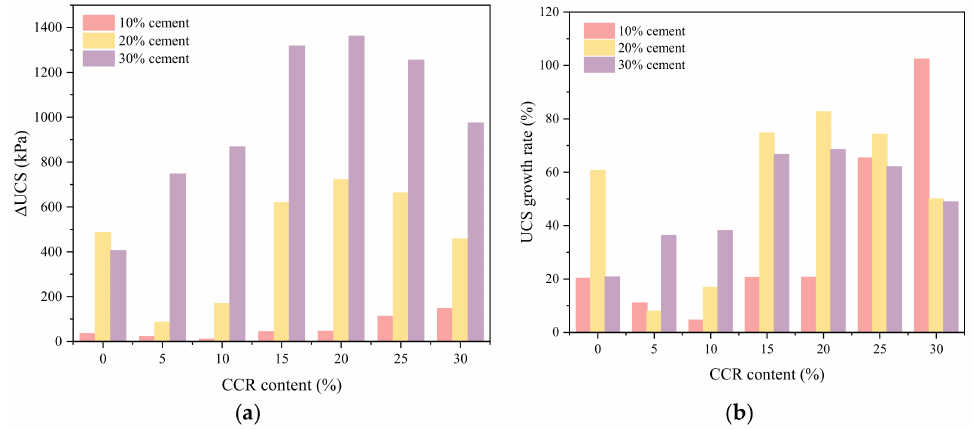
Figure 9. The ( a ) ∆ UCS (7–28) and ( b ) UCS gr(7–28) of CPDS versus the CCR content at different cement